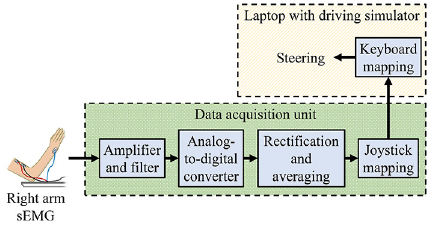
Figure 6 Steering control system for driving simulator